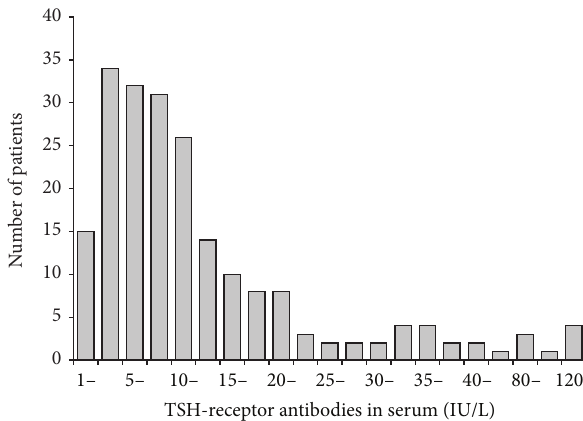
Figure 2: Distribution of thyroid volumes (5mL intervals) in patients with newly diagnosed hyperthyroidism caused by Graves’ disease and enrolled in the RISG study. Male patients: dark grey, female patients: light grey. Among the men, 46.9% had enlarged thyroid ( > 25 mL), whereas this was 53.4% in the women ( > 18mL). this did not reach statistical significance in men ( 𝑟 𝑠 = 0.21 , 𝑃 = 0.25